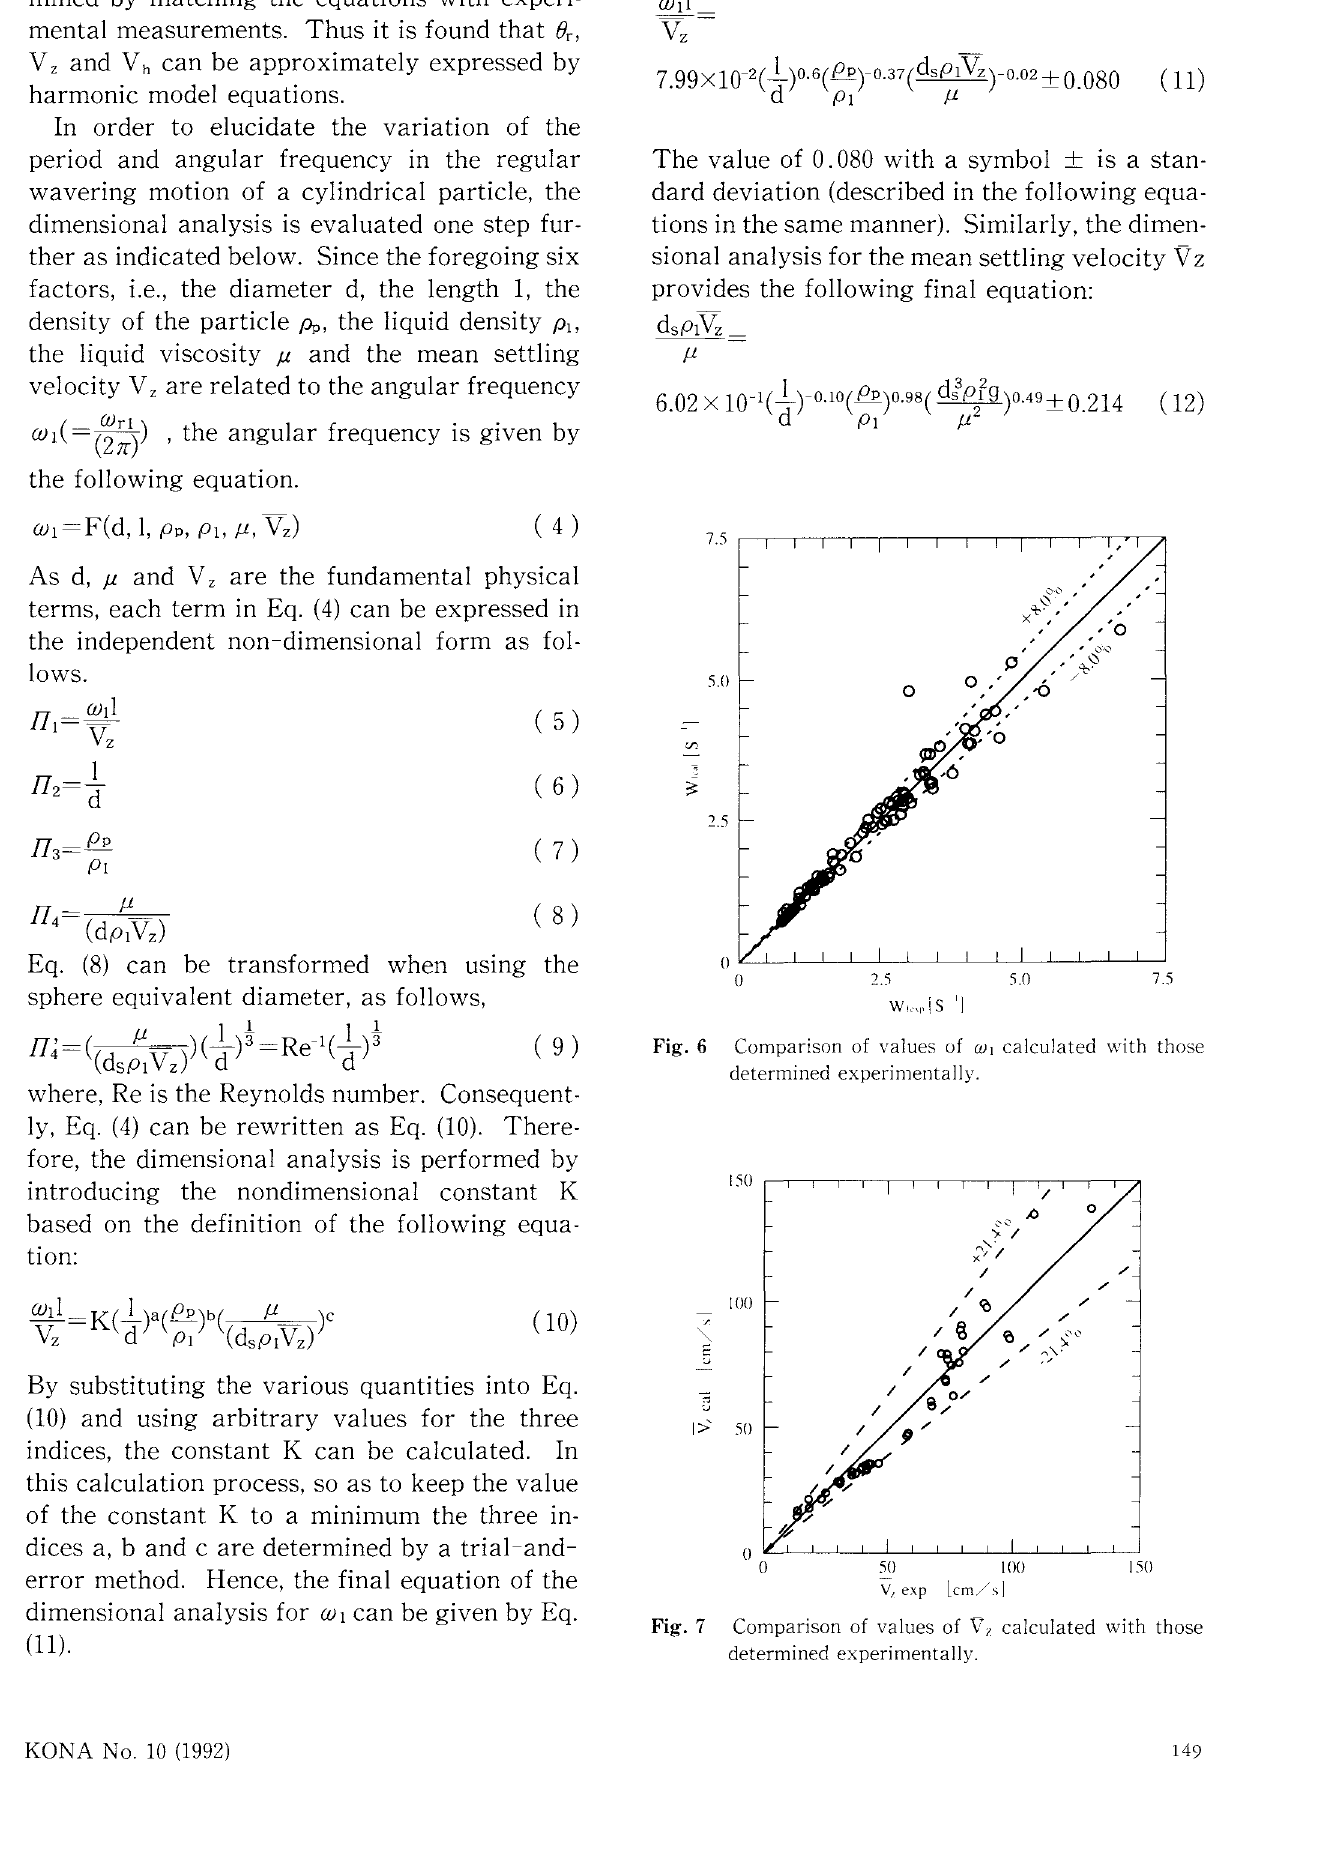
Comparison of values of determined